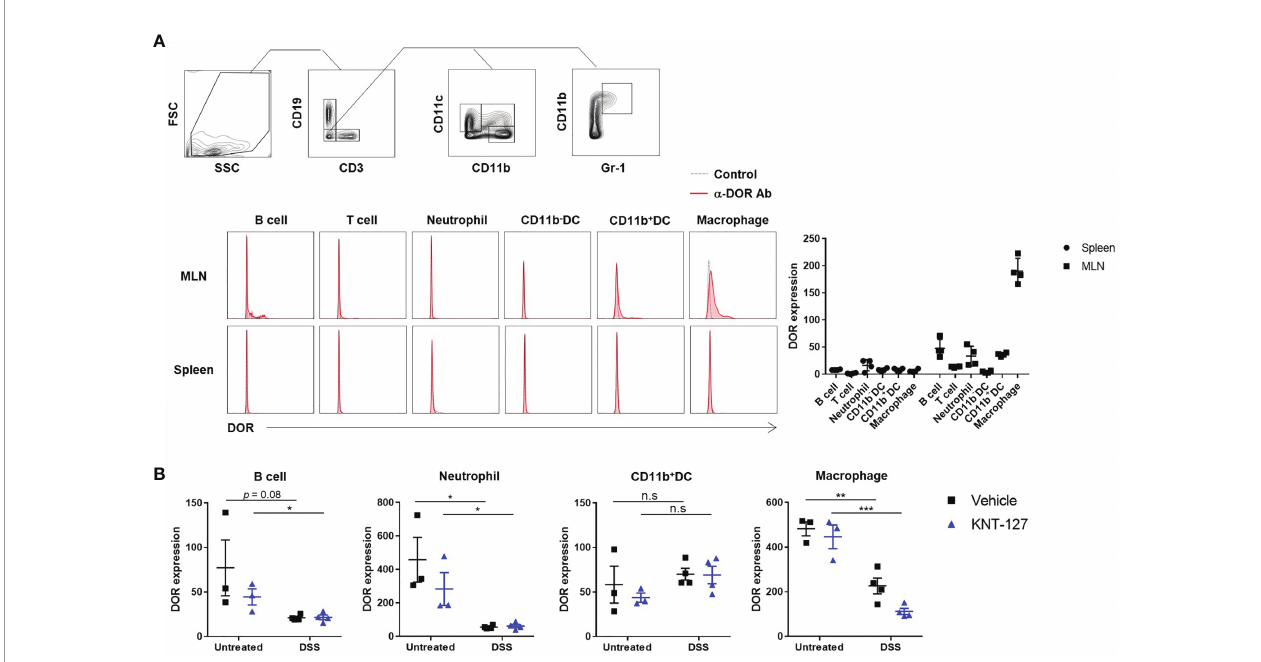
FIGURE 5 | DOR expression levels on immune cells. (A) Cells prepared from the MLNs and spleen of normal mice. Gating strategies (top), typical histograms (bottom left), and MFIs (bottom right, n=4). Control, FITC-labeled anti-rabbit 2nd Ab only; a -DOR Ab, anti-DOR rabbit Ab plus 2nd Ab. (B) Effects of DSS treatment and/or KNT-127 treatment on DOR expression levels on immune cells in the MLNs. The data are shown as the mean ± s.e.m. * P < 0.05; ** P < 0.01; *** P < 0.001; n.s., not signi fi cant (two-tailed Student ’ s